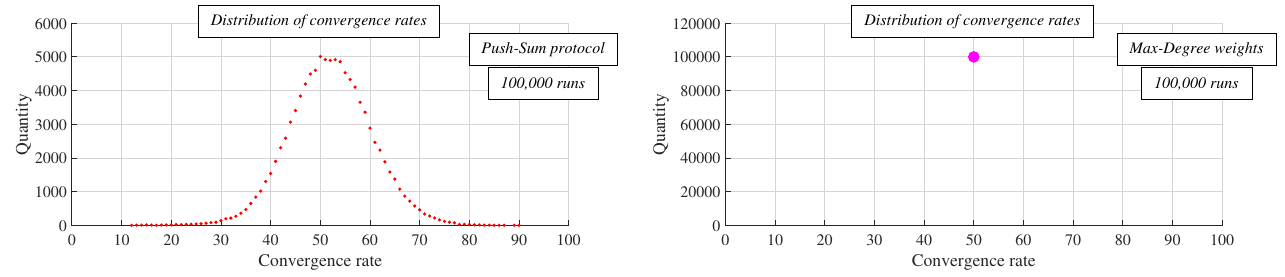
Figure 6. Comparison of gossip Push-Sum protocol with deterministic Max-Degree weights algorithm over three runs—evolution of arithmetic mean estimates.